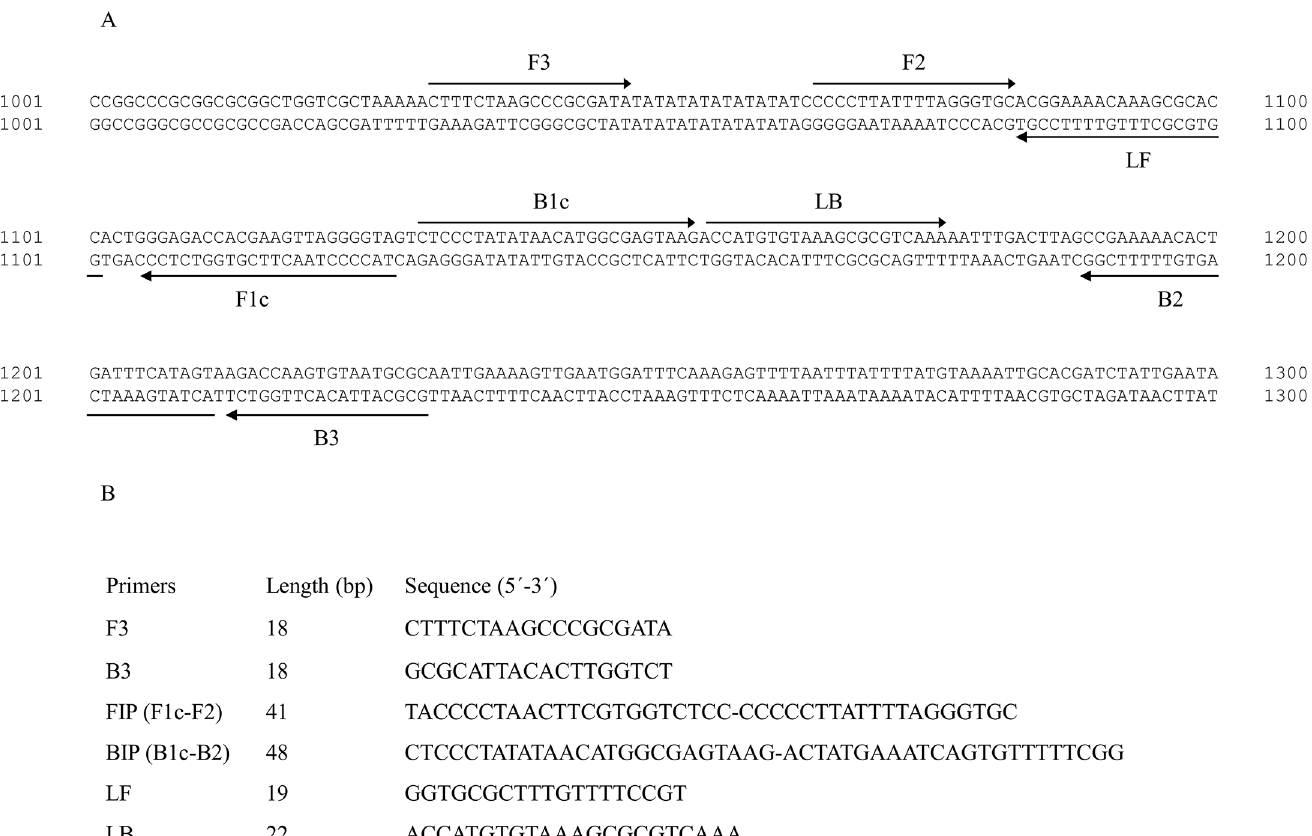
Fig 1. Lamp primer set targeting the selected sequence (GenBank Accession No. AJ223838) for ribosomal intergenic spacer S . haematobium DNA region amplification. (A) The location of the LAMP primers within the selected sequence is shown. Arrows indicate the direction of extension. (B). Sequence of LAMP primers: F3, forward outer primer; B3, reverse outer primer; FIP, forward inner primer (comprising F1c and F2 sequences); BIP, reverse inner primer (comprising B1c and B2 sequences); LF (loop forward primer); LB (loop backward primer).